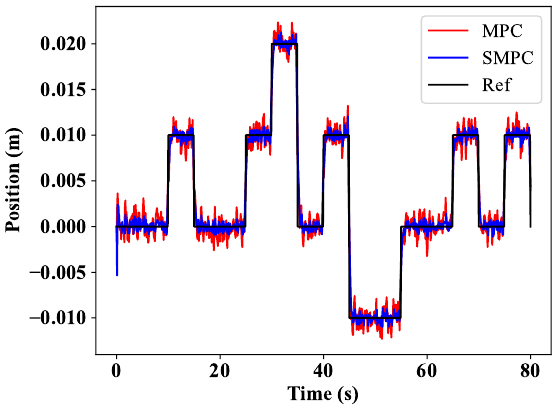
Figure 15. MPC and Stochastic MPC results.